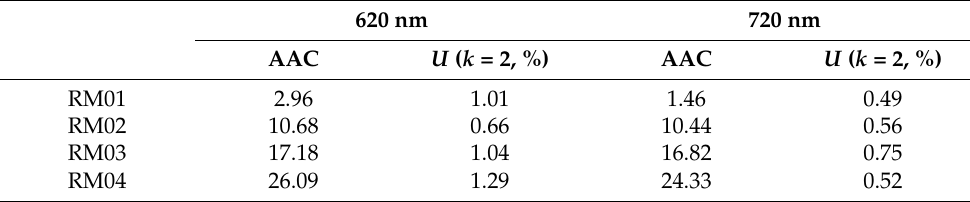
Table 5. AAC and the expanded uncertainties of the four rice reference materials a